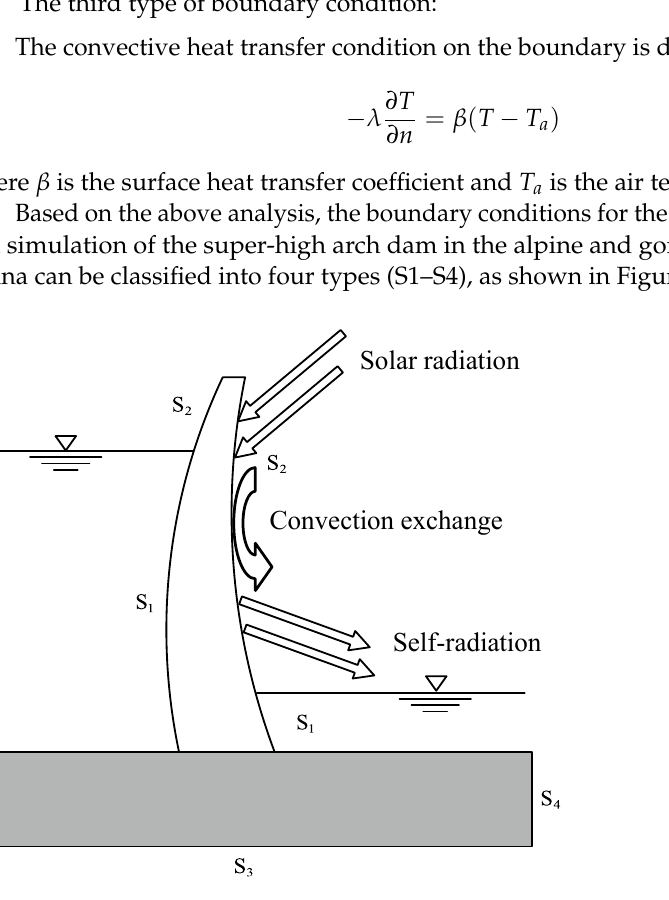
Figure 1. Boundary conditions of the super-high arch dam’s temperature field.